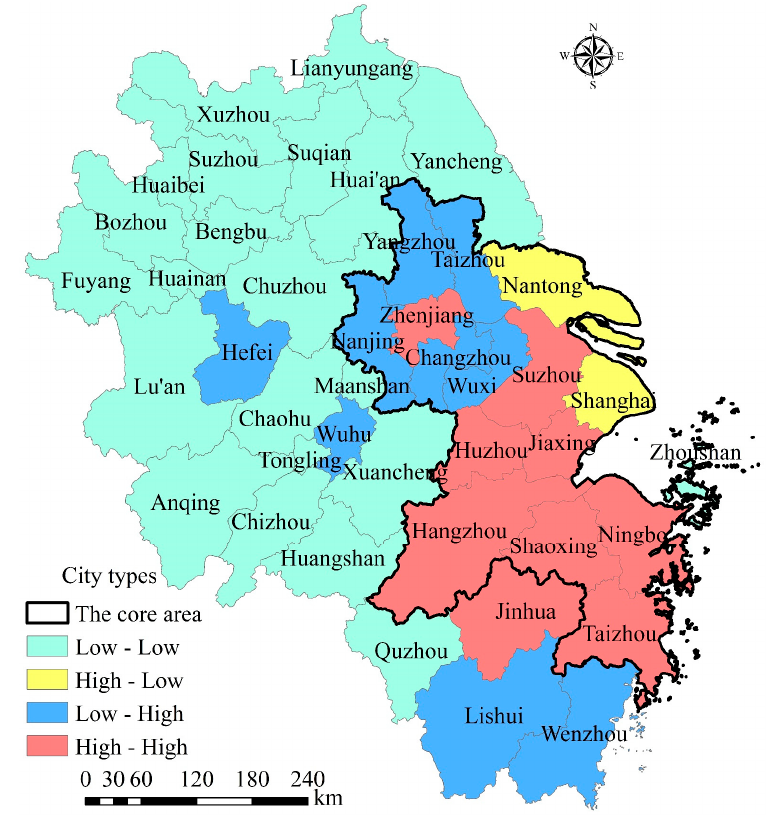
Figure 6. Cities with different types of innovation growth in the YRD.